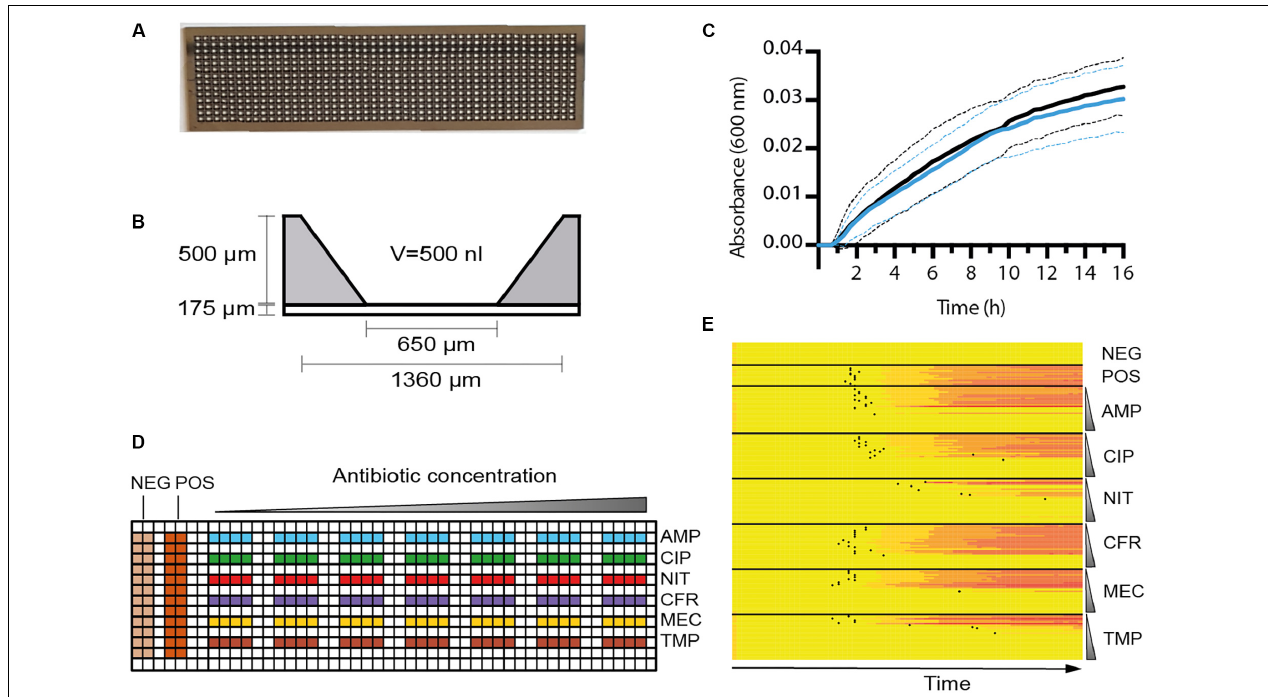
FIGURE 1 | Characterization of the nwSlide as an AST platform. (A) Photograph of a nwSlide (25 mm × 75 mm) holding 672 nanowells in a 14 × 48 matrix. (B) Side view of one nanowell with dimensions and volume (V) indicated. (C) Growth measured at OD 600 of a wt Escherichia coli laboratory strain (W3110, black) and a strain with mutated fnr gene ( BW25113 (cid:49) fnr , blue) in a nwSlide. Circa 200 nanowells were recorded for each strain, dashed lines = SD, n = 3. (D) The design of functionalized nwSlides used for nwASTs. The left side offers 24 non-functionalized nanowells each for negative (NEG., medium only) and positive (POS., inoculated medium) controls of bacterial growth. The antibiotics ampicillin (blue, AMP), ciprofloxacin (green, CIP), nitrofurantoin (red, NIT), cefadroxil (purple, CFR), mecillinam (yellow, MEC), and trimethoprim (brown, TMP) are coated and distributed in separate rows. The antibiotic concentration varies from lowest (left) to highest (right) as indicated schematically above the nwSlide. Each antibiotic is represented by seven twofold dilutions. Each concentration includes four nanowells that serve as technical replicates. Antibiotic concentrations in individual experiments are defined in Section “Materials and Methods.” (E) MIC determination of the reference strain E. coli ATCC 25922 from one nwAST functionalized as in (D) . The heatmap shows OD 600 recordings in each of the 216 nanocultures over 12 h at indicated conditions. A color change from yellow (low OD 600 ) to red (high OD 600 ) in one row indicates bacterial growth in the corresponding nanowell. Negative and positive controls include 24 wells each. For each antibiotic, growth pattern of the 28 nanocultures at 7 antibiotic concentrations is shown. The vertical gradient symbol indicates that nanocultures in the upper rows are exposed to the lowest concentration of antibiotics, whereas a gradual increase leaves the lower rows representing nanowells exposed to the highest concentration. Black dots represent the T lag of each